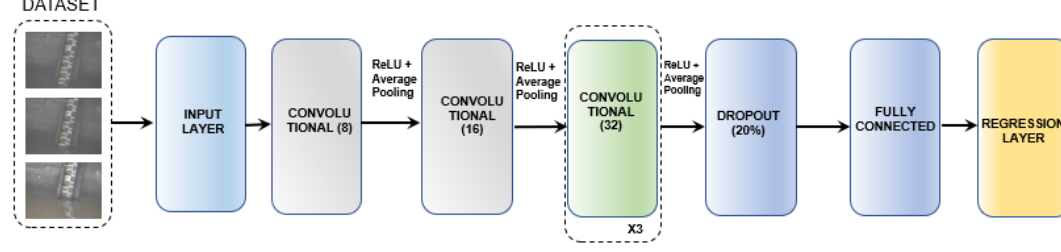
Figure 6. Convolutional neural network